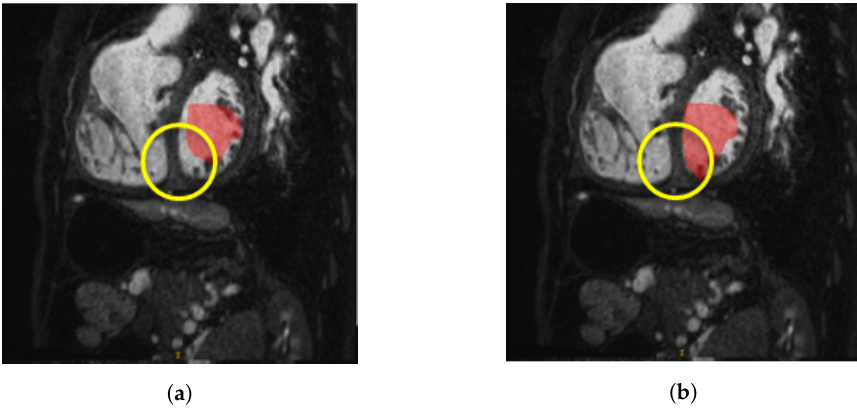
Figure 2. ( a ) Initialization of the smart brush in red and the smart brush is propagated which is illustrated as yellow circle; ( b ) Correct segmented area under the brush using adaptive thresholding and propagation